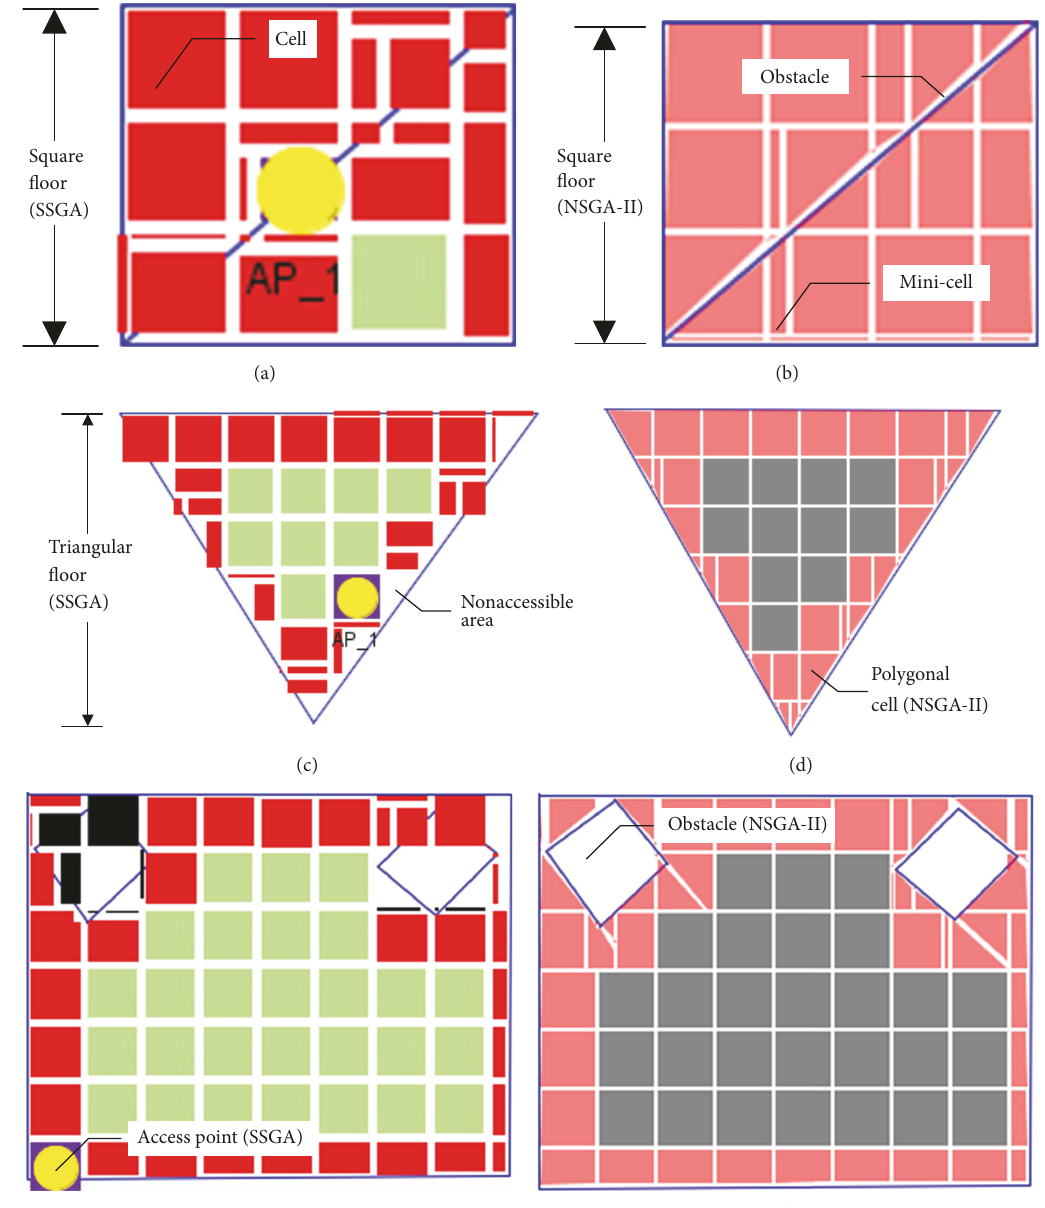
Figure 2: Comparison of the grid structure in SSGA (left) and NSGA-II (right) where red, green, and grey cells stand for covered areas: (a)-(b) square building with diagonal obstacle, (c)-(d) triangular building, and (e)-(f) rectangular building with inner obstacles (e.g.,